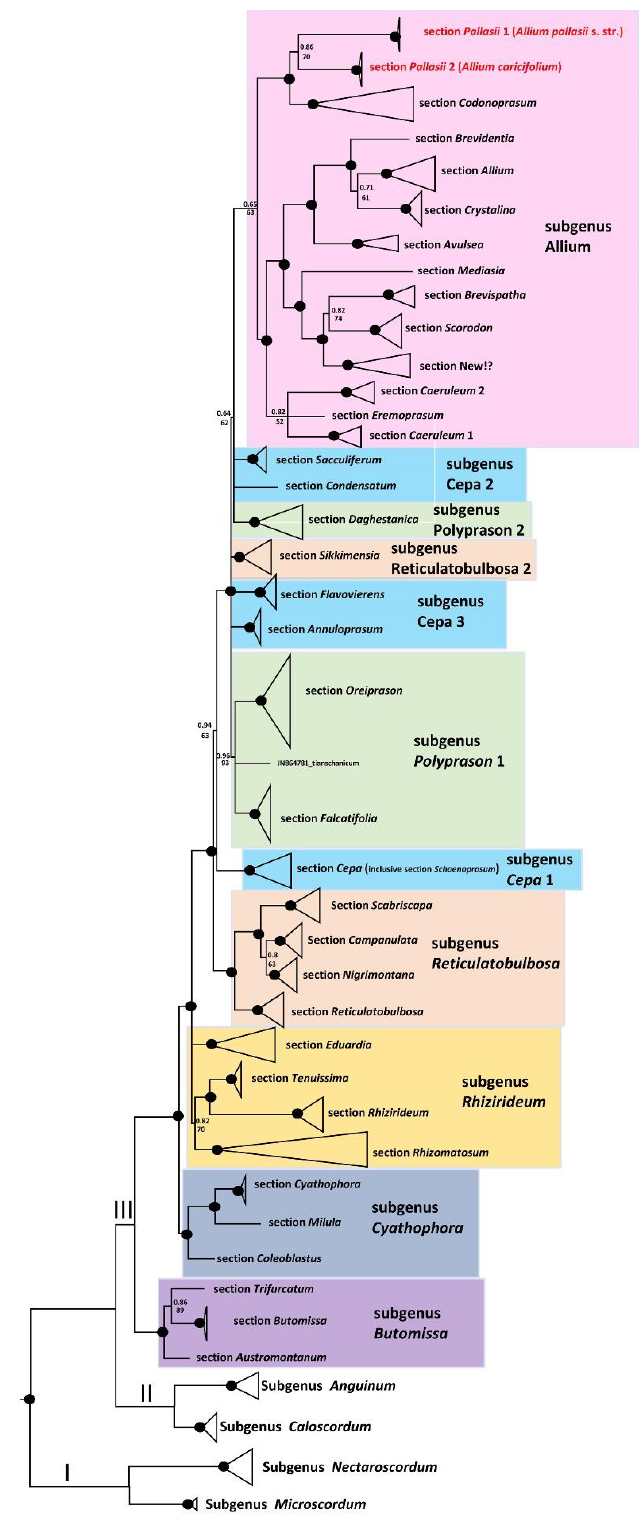
Figure 5. Generalized nrITS tree of the third evolutionary line of genus Allium . Numbers by nodes represent bootstrap support (1000 replicates) and Bayesian probabilities. Roman numerals (I, II, and III) designate clades of three evolutionary lines. The joint presence of Bayesian probabilities over 0.98 and bootstrap support over 95% is indicated with a black dot. Allium pallasii and A. caricifolium clades are sister. Marked red in the tree. For the origin of samples without GenBank accession numbers, see Appendix